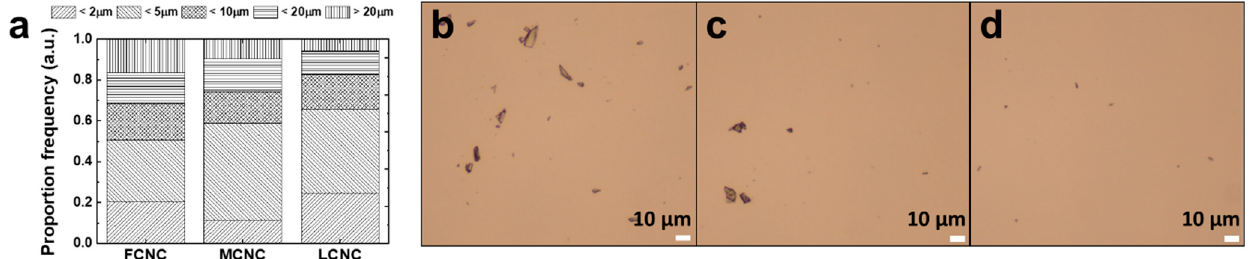
Figure 2. AFM topographic images (on the left) and histograms of the aspect ratio (on the right) from various CNC sources. AFM image shows that the majority of individual CNCs are well dis- persed, which provide a direct comparison in nanoscale. ( a ) FCNC, ( b ) MCNC, and ( c ) LCNC.